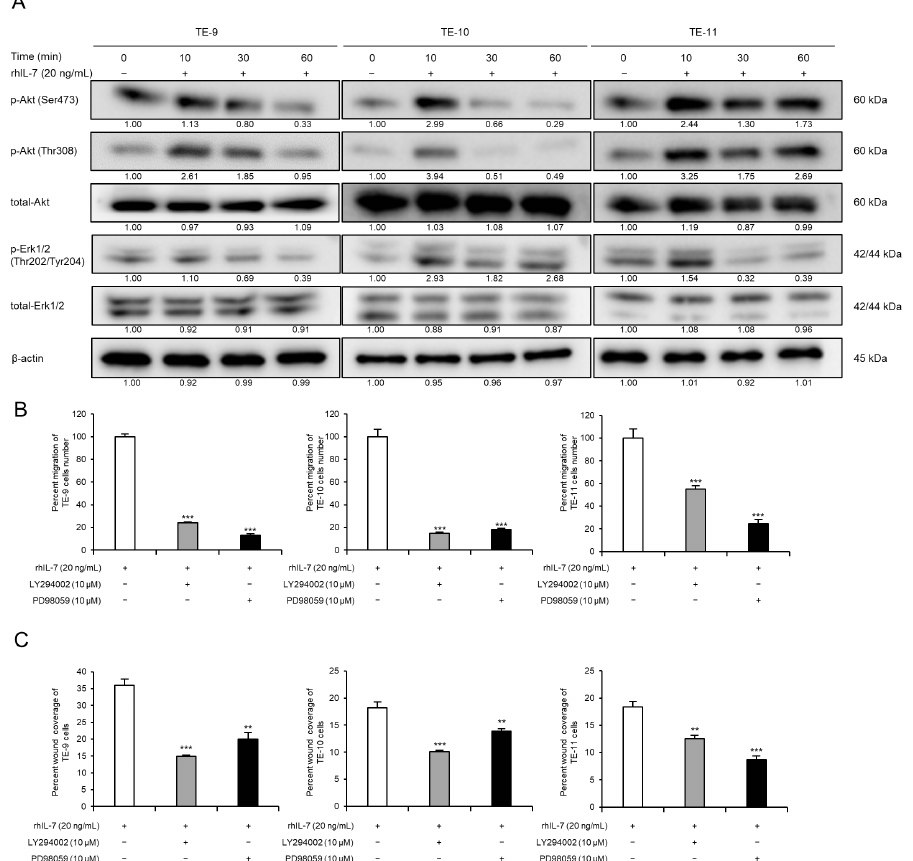
Figure 5. IL-7/IL-7R axis promotes migration of ESCC cells via Akt and Erk1/2 activation. ( A ) Western blot analyses demonstrated phosphorylated or total Akt and Erk1/2 levels in TE-9, -10, and -11 cells. Under serum-free conditions, TE-9, -10, and -11 cells were treated with recombinant human IL-7 (rhIL-7, 20 ng/mL) for 0, 10, 30, and 60 min. β -actin was used as an internal control. The expression level was normalized using ImageJ software; the relative value was set as 1.00 for rhIL-7-untreated cells. ( B ) Transwell migration assays were performed to investigate the effect of PI3K or MEK1/2 inhibitors on the migration of rhIL-7-treated ESCC cells. Transwell migration assays of TE-9, -10, and -11 cells treated with rhIL-7 (20 ng/mL) and inhibitors against PI3K (LY294002, 10 µM) or MEK1/2 (PD98059, 10 µM) were performed. The number of migrated cells was counted in four randomly selected areas. ( C ) Wound healing assays were performed to investigate the effect of PI3K or MEK1/2 inhibitors on the migration of rhIL-7-treated ESCC cells. Wound healing assays of TE-9, -10, and -11 cells treated with rhIL-7 (20 ng/mL) and inhibitors against PI3K (LY294002, 10 µM) or MEK1/2 (PD98059, 10 µM) were performed. After incubation for a specific duration, the percentage wound coverage was measured and compared. Data are presented as the mean ± SEM. N.S., not significant. * * p < 0.01, ** * p < 0.001.